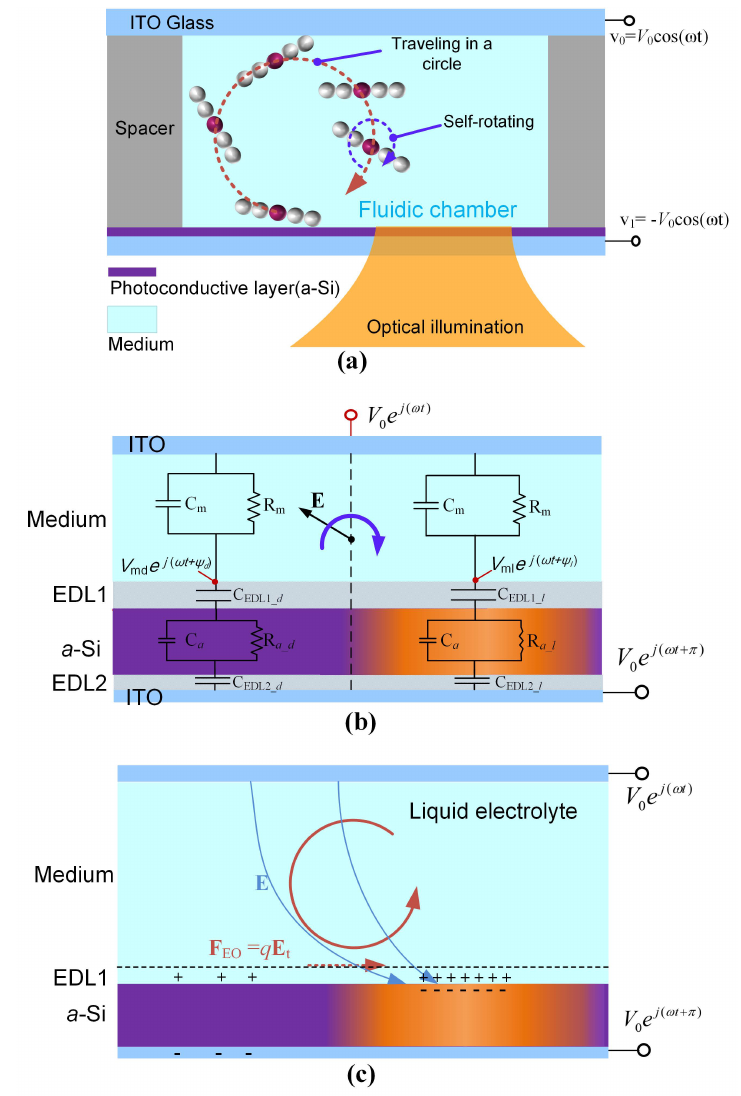
Figure 1. Schematically illustration of the optoelectronic tweezers (OET) device configuration and the principle for generating rotating electric field and alternating current electroosmotic (ACEO) flows. ( a ) Conceptual illustration of the self-rotation and circular traveling of an entire particle chains in an OET device. The motion trajectories of the particle chain around the edge of illuminated area are indicated by dashed curve lines. ( b ) Device structure and mechanism for generating the rotating electric field around the border between dark and light regions. ω is the angular frequency, t is time and V is amplitude of alternating 0 current (AC) voltage. The electrical double layers (EDL1 and EDL2) are formed at the interface of photoconductor and medium, and the interface of indium tin oxide (ITO) and a-Si:H, respectively. ( c ) Electroosmotic fluid roll formed around the border between light and dark regions. F , q and E are electroosmotic force, charge of counterions and tangential EO t electric field at interface between photoconductive layer and medium,